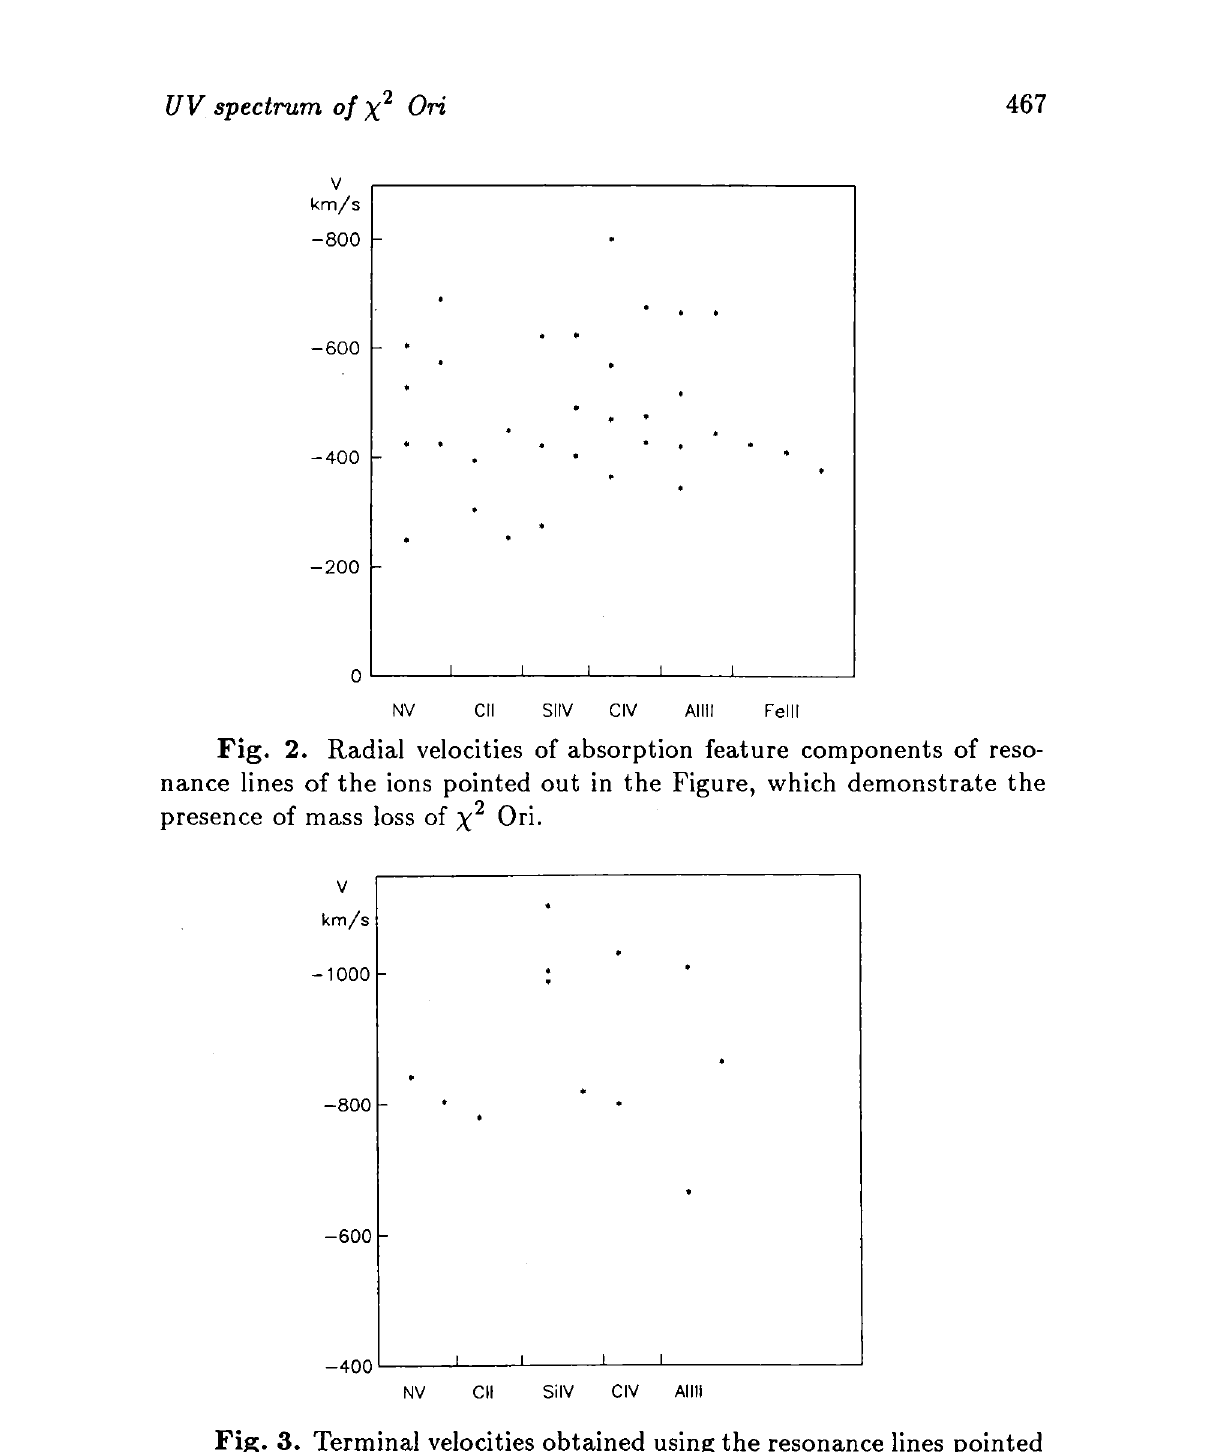
Fig. 3. Terminal velocities obtained using the resonance lines pointed out in the